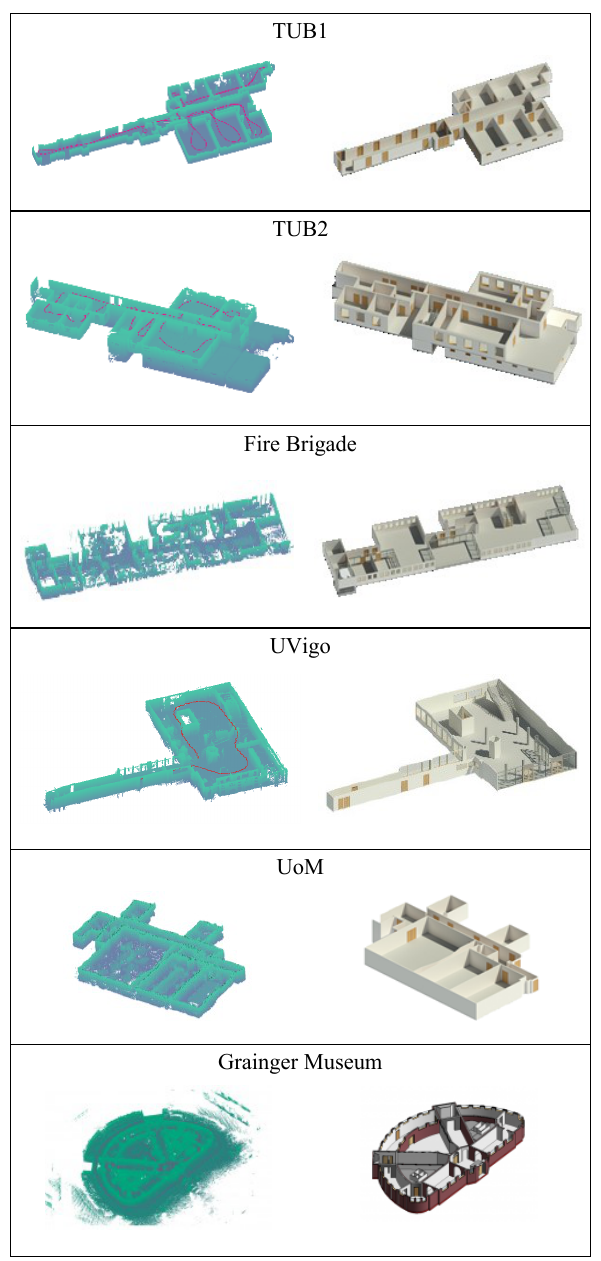
Table 1. Characteristics of the benchmark dataset and the indoor environments.